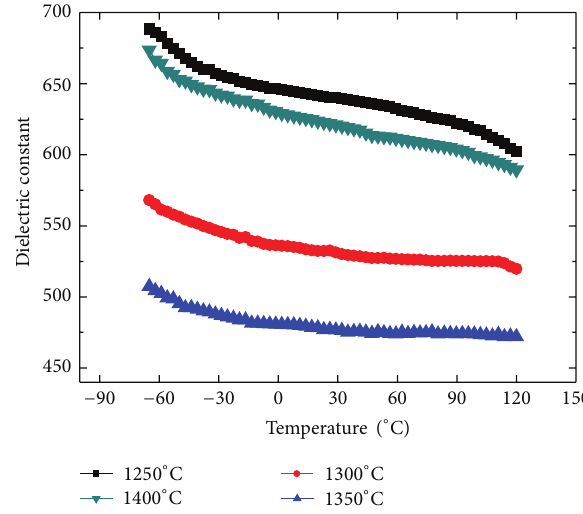
Figure 5: Dielectric constant variation against frequency at 25 ∘ C for CaTiO 3 sintered at 1250 ∘ C, 1300 ∘ C, 1350 ∘ C, and 1400 ∘ C, respectively.